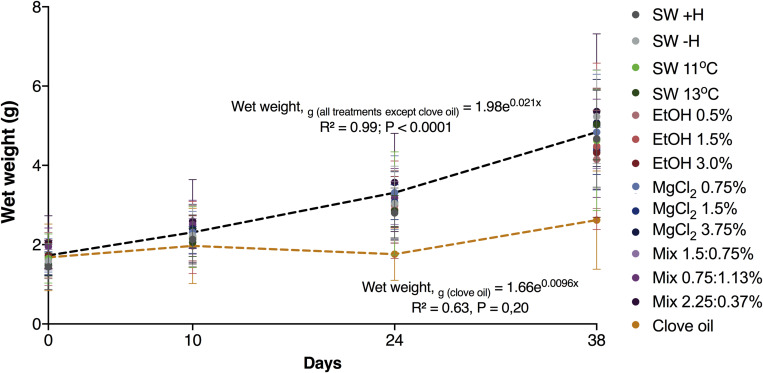
Mean wet weight (±SD) of Octopus maya juveniles exposed or not to the anesthetic agents. All treatments except clove oil (continuous line): Wet weight (g) = 1.60e0.28 (T, days); clove oil (dashed line): wet weight (g) = 1.53e0.0089 (T, days). ANCOVA analysis showed differences in slopes at p < 0.0006 levels between clove oil and the rest of the treatments (see Supplementary Table S2).